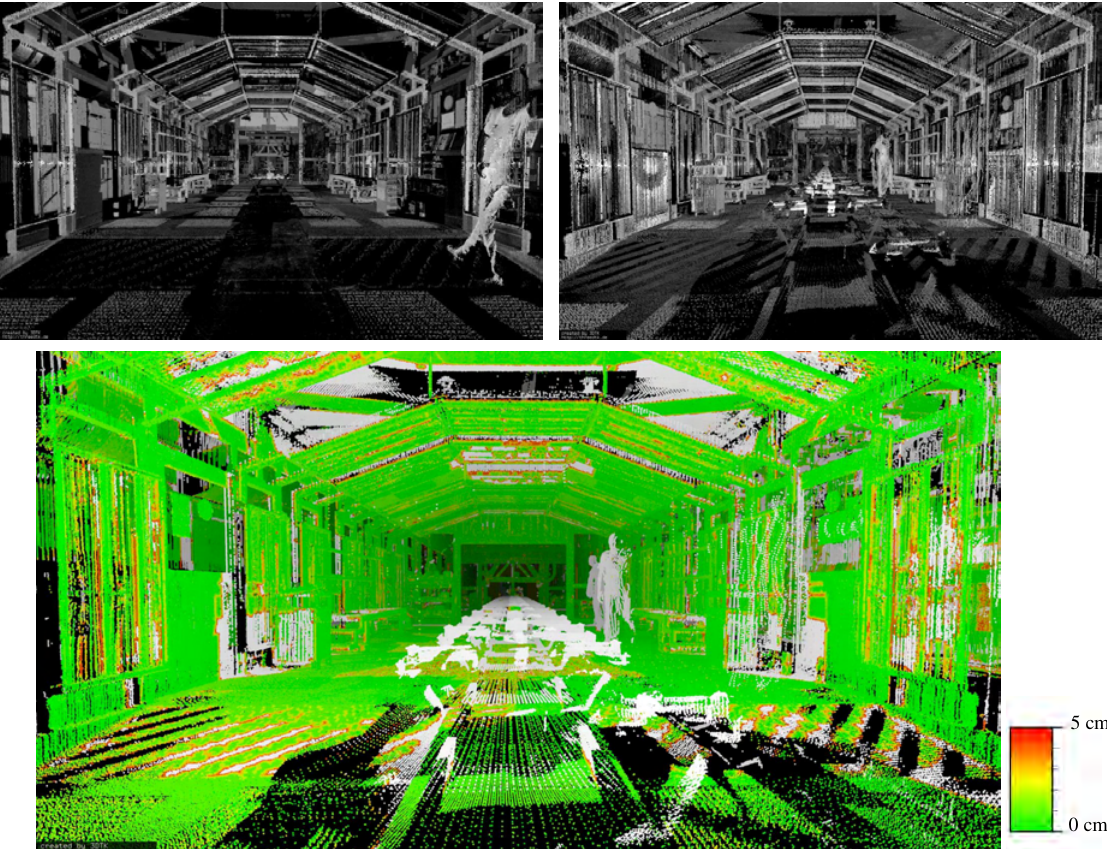
Figure 5: Above left: 3D Point Cloud acquired in a stop-scan-and-go fashion. Above right: Point Cloud acquired in continuous motion. Below: Derivation of the two point clouds in a centimeter scale.